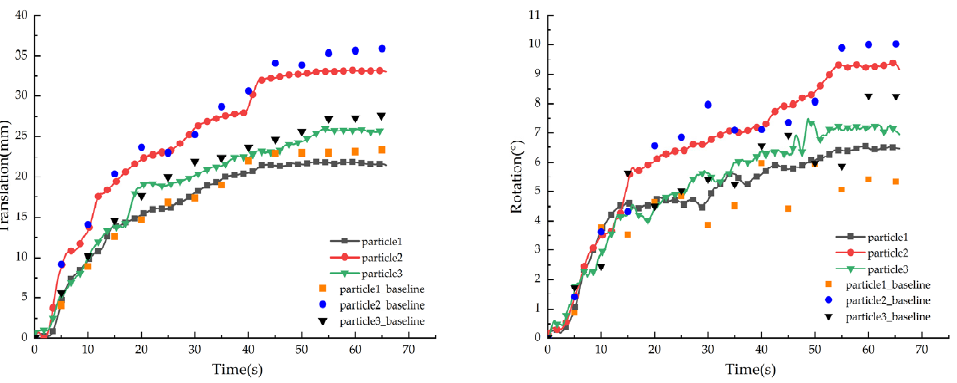
Figure 9. Motion information of some rock particles.